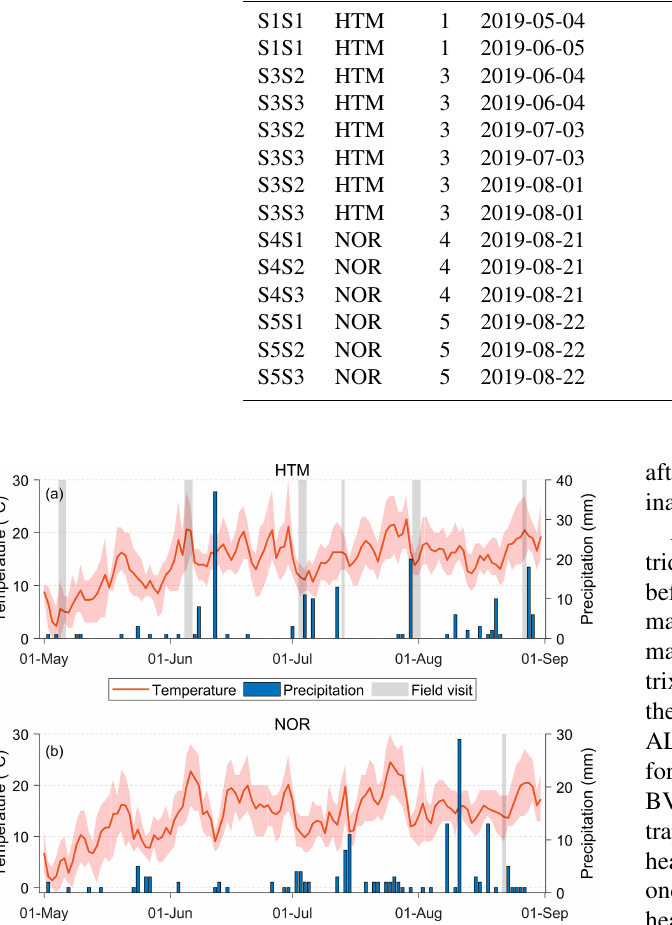
Figure 2. The daily average temperature (red line) with daily min- imum and maximum temperature (red shade) and total daily pre- cipitation (blue bars) for the study sites in (a) Hyltemossa and (b) Norunda. The field visits are marked in grey. The weather data were acquired from the ICOS research stations at the study sites (Heliasz, 2020; Mölder,